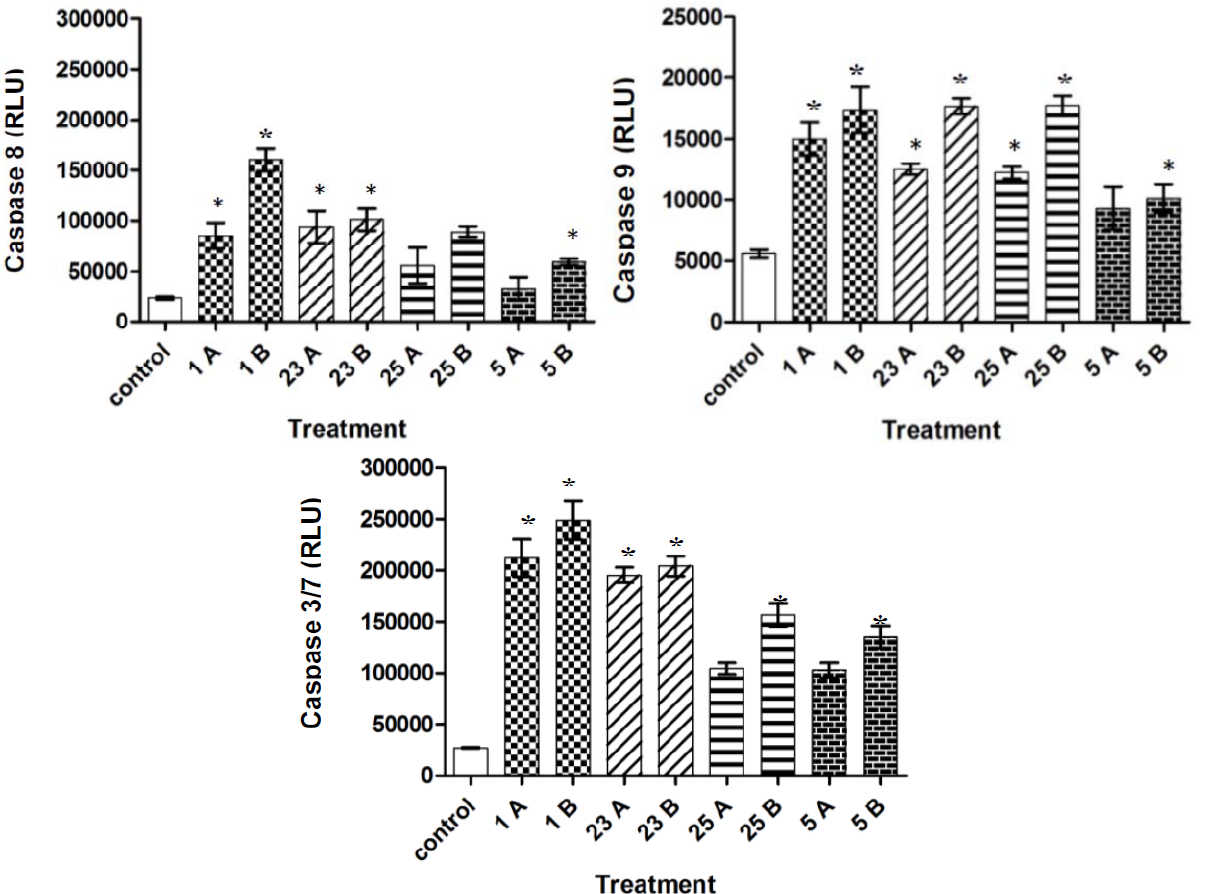
Figure 4. Relative luminescence expression (RLU) of caspase 3/7, 8 and 9 in the MCF7 cells treated with different concentrations compounds. (1A- 3 µg/mL; 1B- 6 µg/mL), (23A- 3 µg/mL; 23B- 6 µg/mL), (25A- 2 µg/mL; 25B- 4 µg/mL) and (5A- 3 µg/mL; 5B- 6 µg/mL). Triplicates of each treatment group were used in each independent experiment. The statistical significance is expressed as *, p <